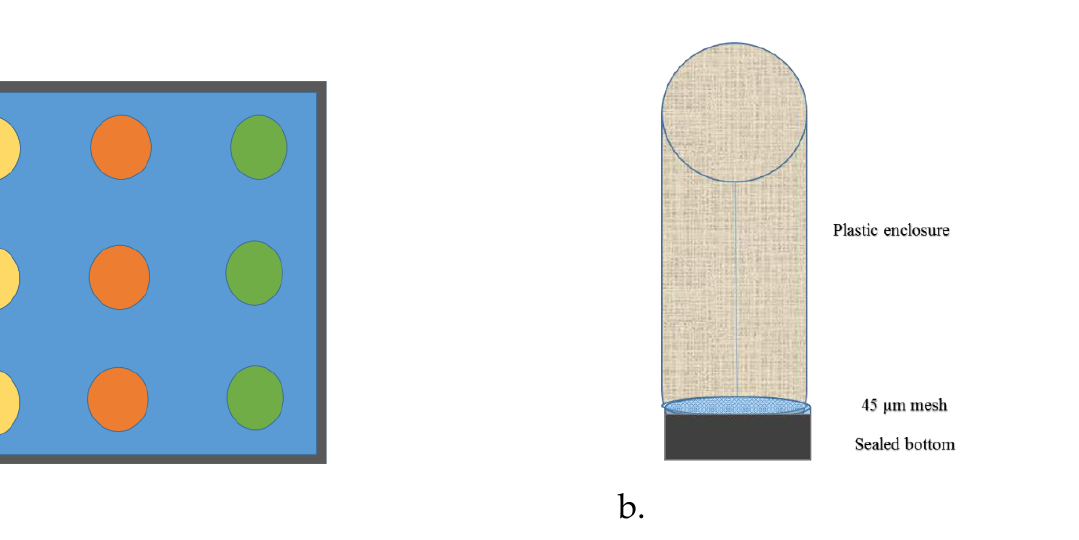
Figure 1. ( a ). Experimental setup of 3 cylindrical enclosures in a sealed compartment and 3 divisions in each aquaria. The color represents the type of copepod in triplicate. ( b ). The design of the enclosure with plastic wall and 45 µm base and sealed bottom.